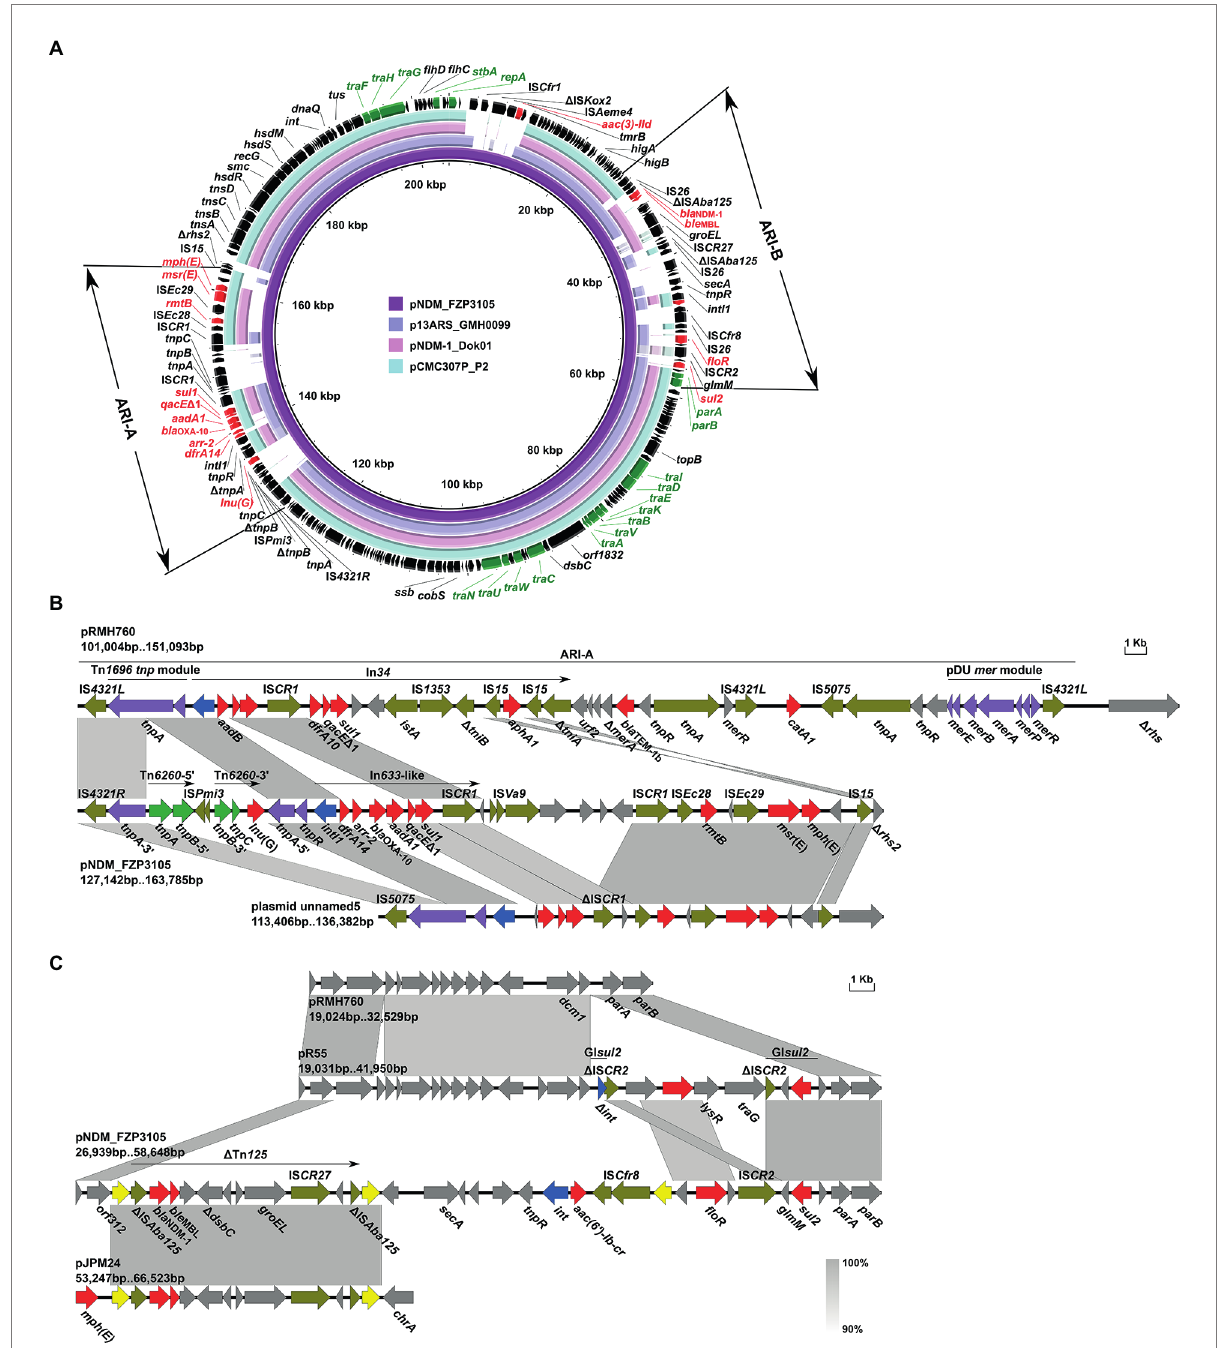
FIGURE 5 Genetic features of pNDM_FZP3105. (A) Circular comparison of pNDM_FZP3105 with pCMC307P_P2, p13ARS_GMH0099 and pNDM-1_Dok01. Arrows on the outer ring indicate deduced ORFs and their orientations. Genes for replication ( repA ), conjugal transfer ( tra ), and plasmid maintenance ( stbA , parAB ) are highlighted in green. ARGs are highlighted in red. Two antibiotic resistance islands, ARI-A and ARI-B, are indicated. (B) Organization of the ARI-A of pNDM_FZP3105, and comparisons to related regions. (C) Organization of the ARI-B of pNDM_FZP3105, and comparisons to related regions. Genes are denoted by arrows, and ARGs, integrase genes, IS 26 , and other transposase genes are highlighted in red, blue, yellow, and olive, respectively. The Tn 1696 tnp and pDU mer modules are indicated in purple, and Tn6260 is in green. Regions of >90% identity are indicated by grey shading. Δ represents truncated genes.